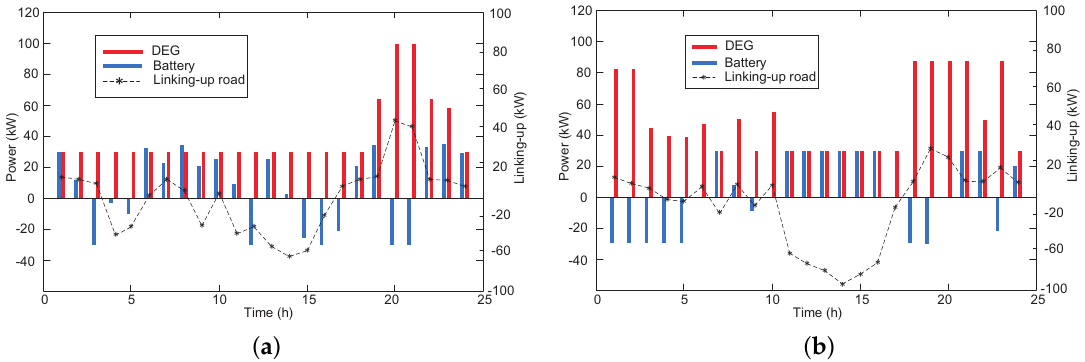
Figure 7. Output power of the storage batteries and the diesel generator in the microgrid; ( a ) the operation cost minimum, ( b ) the emission cost minimum. The comparative convergence of the best solutions of three different methods for the operation cost, emission cost, power loss cost and total cost are shown in Figure 8. From these figures, it is shown clearly that the proposed PSO-OGSA converges smoothly to the optimum value in the optimization process. The proposed PSO-OGSA algorithm outperforms the PSO and GSA methods as a whole; it has the advantage of reducing emission cost and loss cost. The target values of